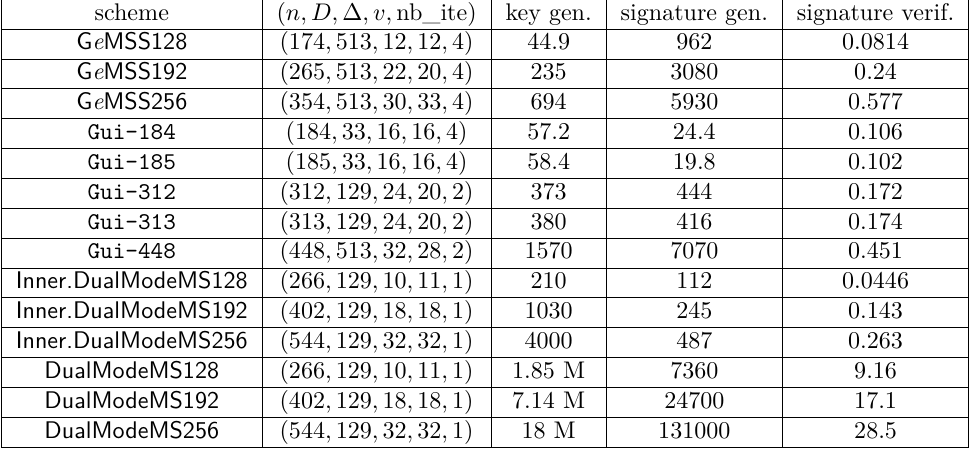
Table 30: Number of mega cycles for each cryptographic operation with MQsoft . We use a Haswell processor (ServerH). Turbo Boost is not used. scheme